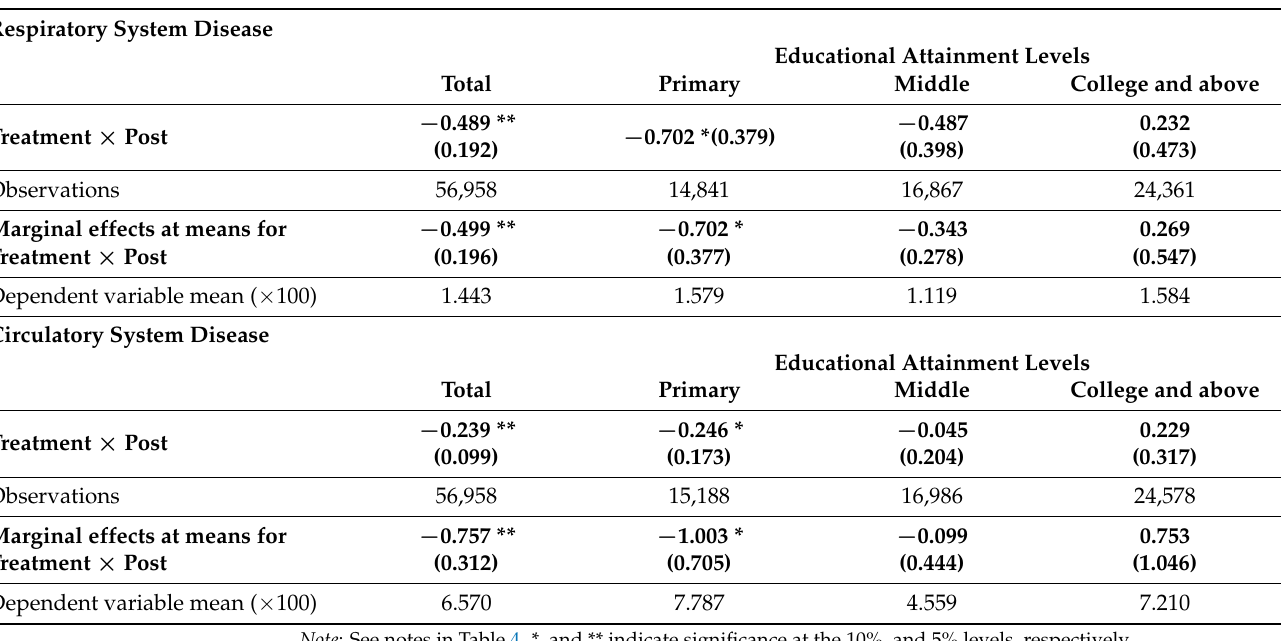
Table 5. Logit estimates: effects of APPCAP on chronic conditions, by education